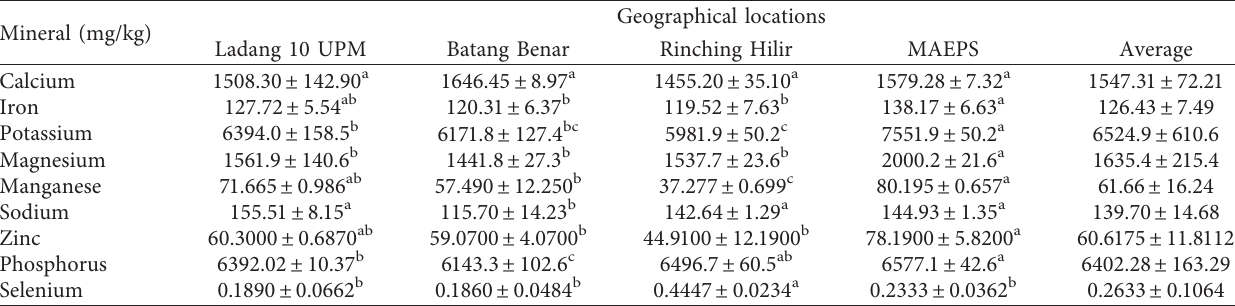
Table 5: Mineral content (mg/kg) of H. itama bee bread samples.